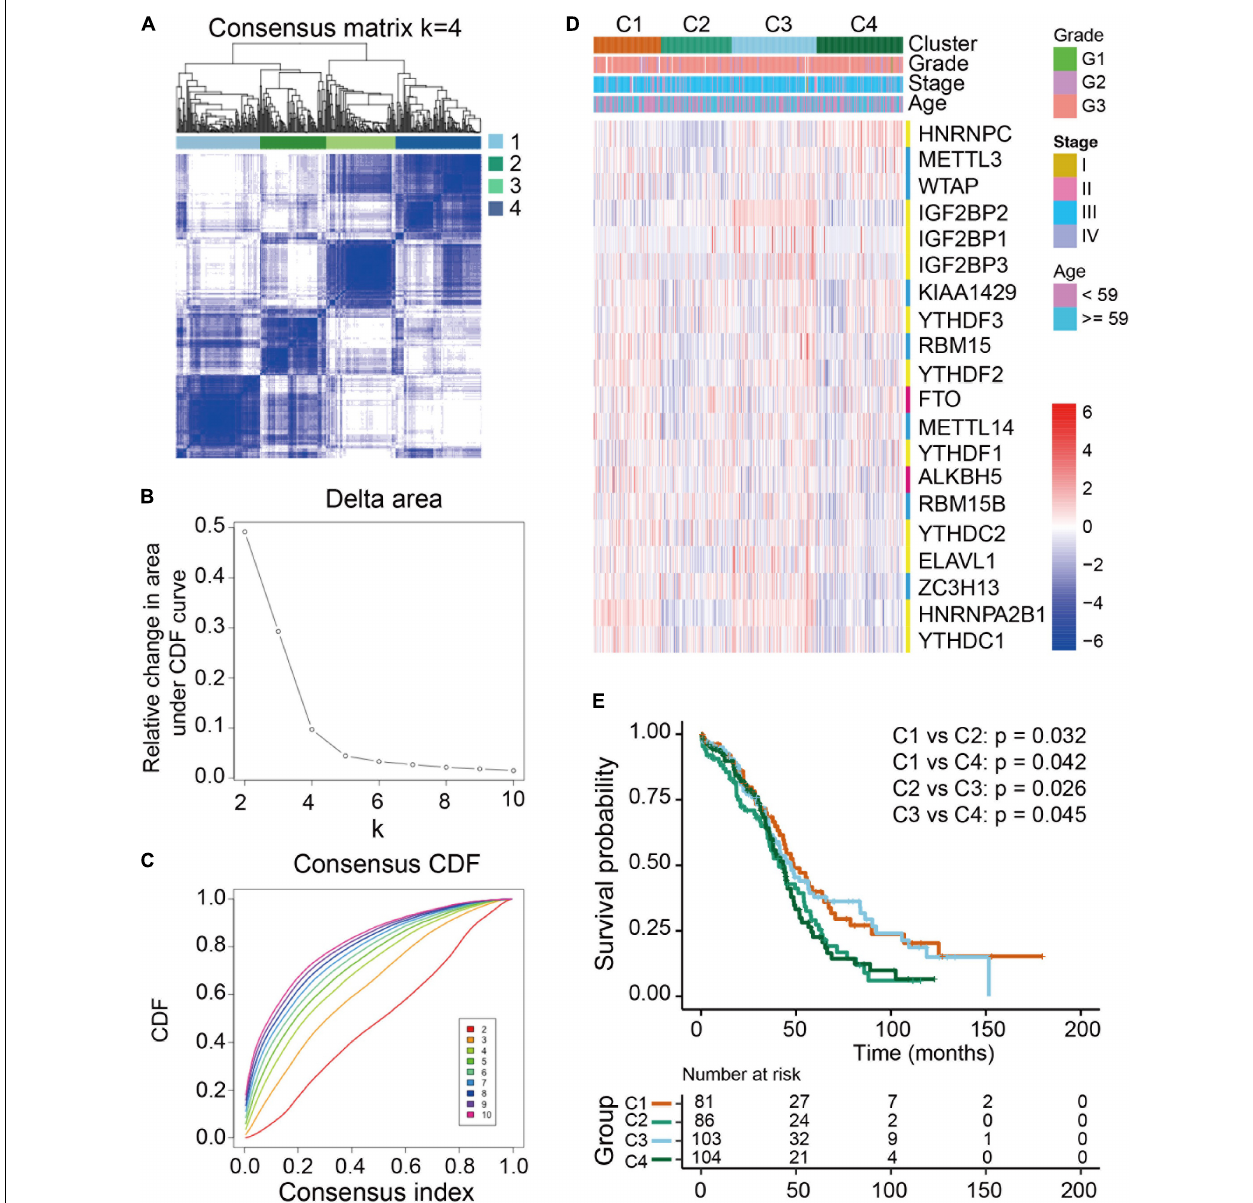
FIGURE 3 | Differential clinicopathological features and overall survival of ovarian cancer in four clusters with distinct m 6 A RNA methylation regulator features. (A) Consensus clustering cumulative distribution function (CDF) for k = 2-10. (B) Relative changes in the area under the CDF curve at k = 2-10. (C) Consensus clustering matrix for k = 4. (D) Heatmap with the clinical and pathological characterizations for clusters according to m 6 A RNA methylation regulator consensus clustering. (E) Kaplan-Meier overall survival curves of the four clusters.